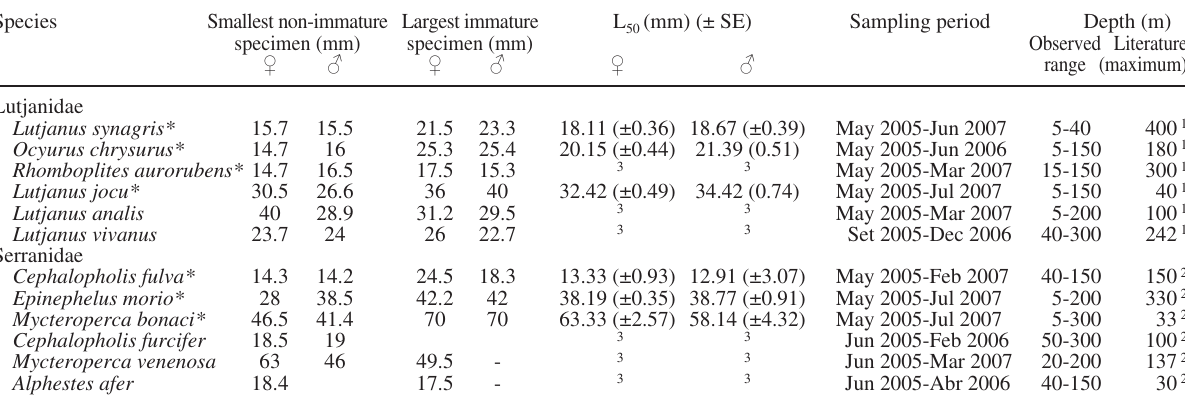
Table 4. – Summary data for the most frequent species of snapper (Lutjanidae) and groupers (Serranidae) in the Abrolhos Bank reef fisheries. Species Smallest non-immature Largest